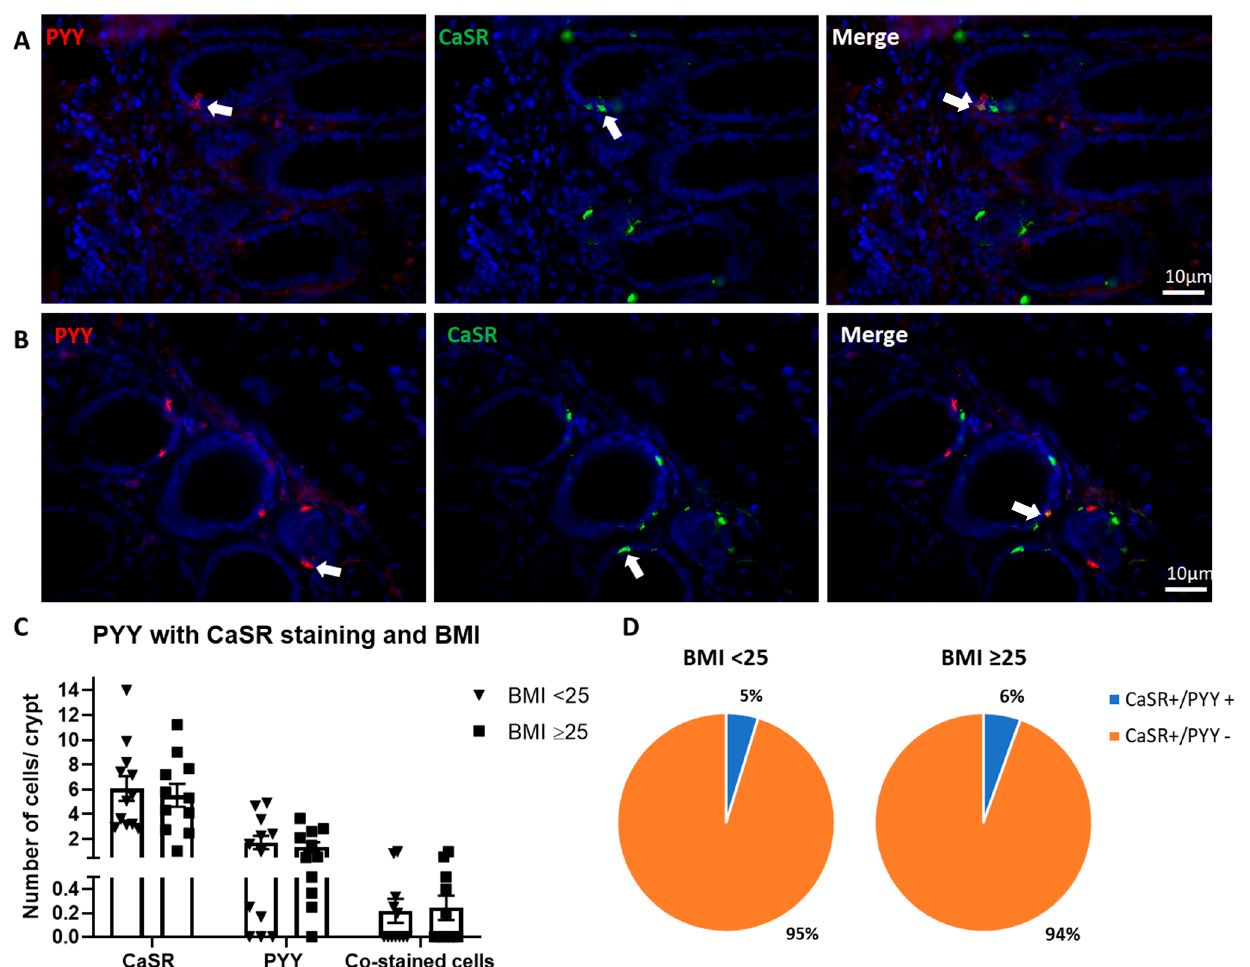
Figure 6. Serotonin and CaSR immunohistochemistry expression in human colon. ( A ): Representative image from BMI < 25 patient tissue staining for PYY (red) and CaSR (green). ( B ): Representative image BMI ≥ 25 patient tissue staining for serotonin (red) and CaSR (green). Arrows denote PYY and CaSR co-stained cells. ( C ): Number of cells per crypt for CaSR, PYY and cells co-stained with both PYY and CaSR, samples differentiated as BMI < 25 ( n = 12) and BMI ≥ 25 ( n = 11). ( D ): Proportion of cells per crypt that are CaSR+/serotonin+ or CaSR+/serotonin- in patients with a BMI < 25 and BMI ≥ 25. Scale bars represent 10 μ m.